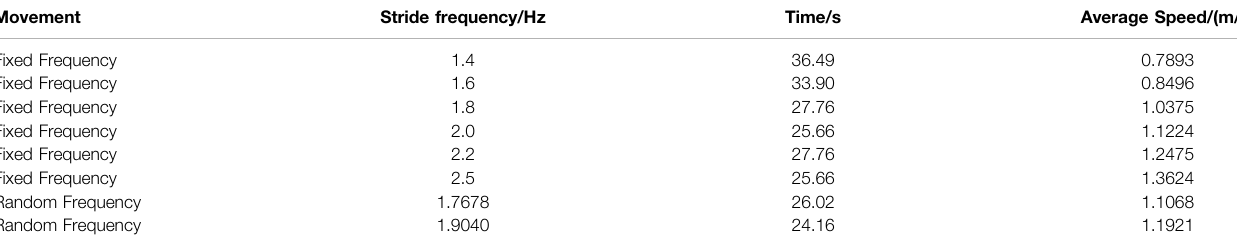
TABLE 7 | Experimental data of tester 4 walking at different step frequencies.